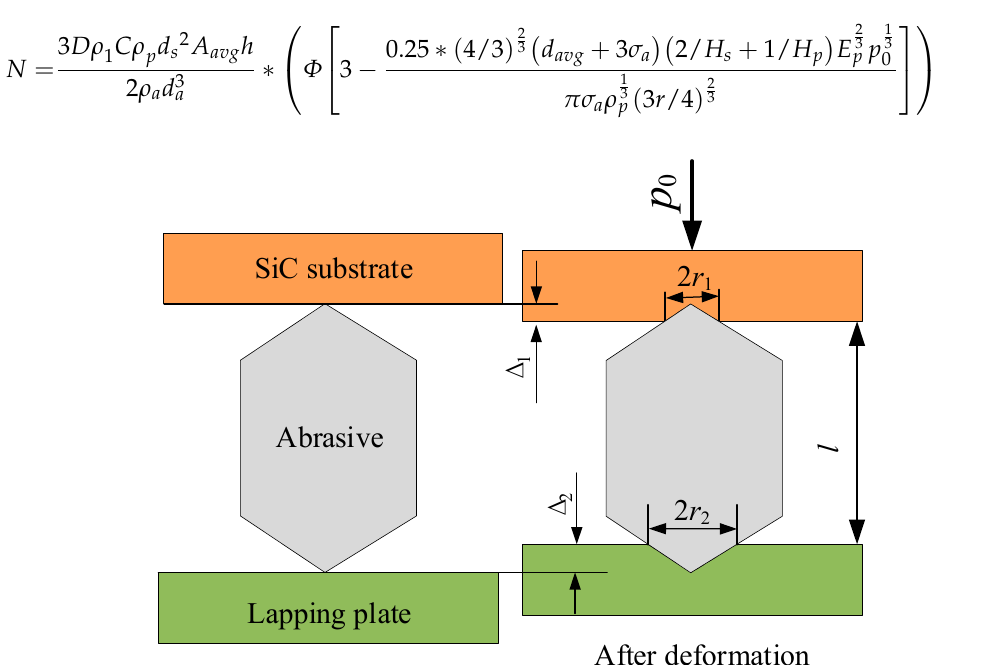
Figure 4. The contact model among an abrasive, an SiC substrate, and a lapping plate. In Figure 4 and related equations, p 0 is the lapping normal-pressure applied to the substrate; ∆ , ∆ 1 , ∆ 2 , r 1 , r 2 , and l are the total deformation amount among the SiC substrate and the lapping plate, the total deformation amount among the substrate and the abrasive, the total deformation amount among the abrasive and the lapping plate, the contact region radius of the substrate and the abrasive, the contact region radius of the abrasive and the lapping plate, and the distance between the substrate surface and the lapping plate surface, respectively; H s , E s , v s , d s , and ρ s are the hardness, Young’s modulus, Poisson’s ratio, diameter, and density of the SiC substrate, respectively; H p , E p , and v p are the hardness, Young’s modulus, and Poisson’s ratio of the lapping plate, respectively; r , ρ p , and h are the average curvature radius, distribution density, and average deformation height of a single projection of the lapping plate, respectively; v is the relative velocity of the substrate and lapping plate; d a , d avg , σ a , and ρ a are the size, average size, standard deviation, and density of the effective active abrasive in the lapping area, respectively; A avg is the average contact area between the substrate and the projection of the lapping plate; and ρ 1 , C , and D are the density, concentration, and dilution ratio of the abrasive before dilution, respectively. By substituting Equations (3) and (5) into Equation (4), the mathematical model for the MRR m of SiC during the lapping process can be obtained, as shown in Equation